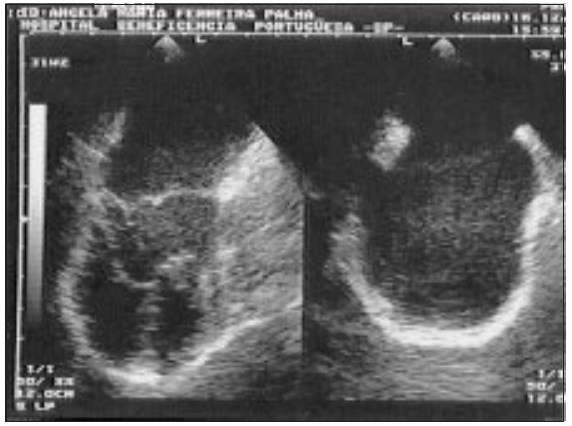
Fig. 4 – Ecocardiograma transesofágico. A: Corte longitudinal mos- trando átrio esquerdo e ventrículo esquerdo. B: Corte longi- tudinal mostrando o imenso átrio esquerdo localizado poste- riormente ao ventrículo esquerdo.